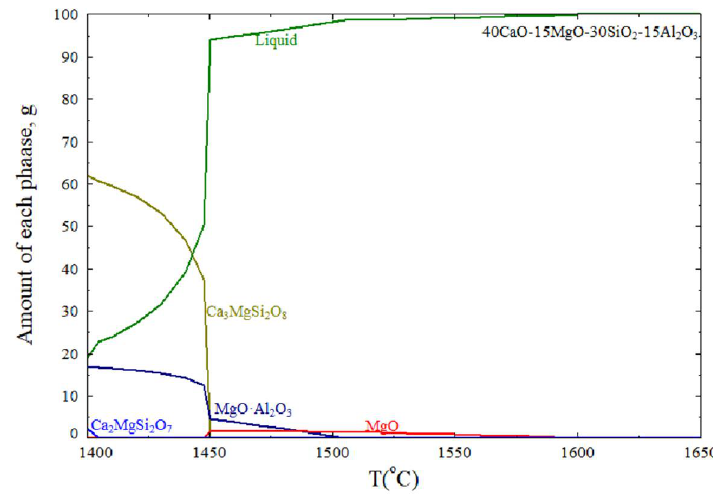
Figure 9. Precipitation of inclusions during solidification.